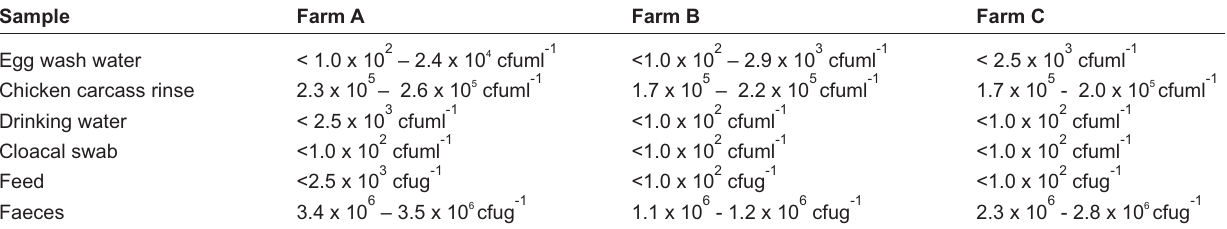
Table-3: MPN for coliform observed in culled chicken layers Sample